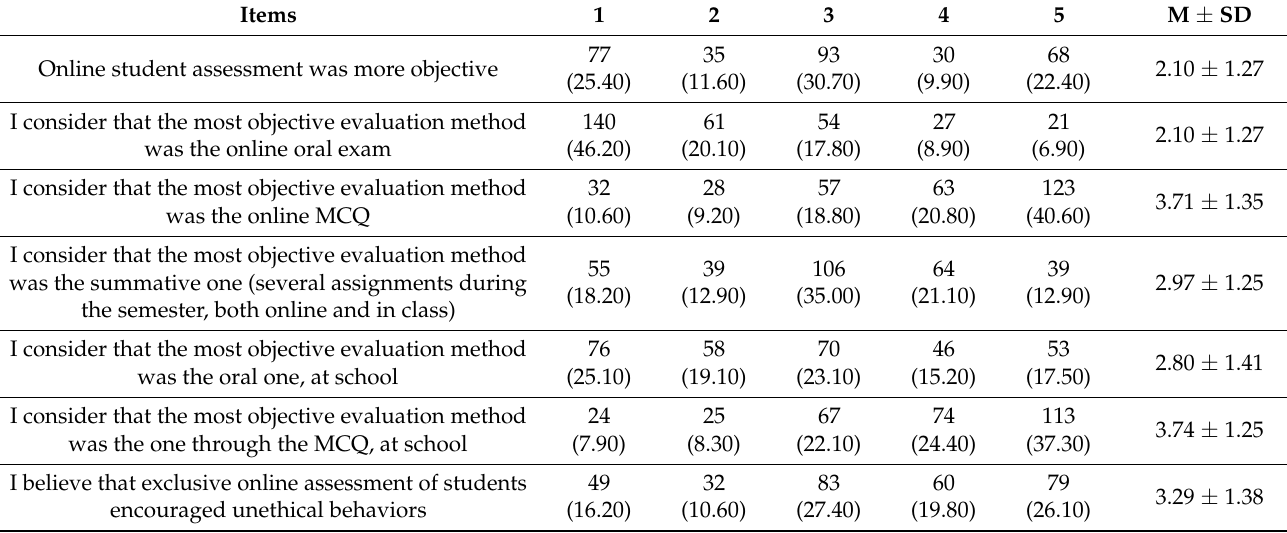
Table 5. Self-rated items regarding students ‘opinions related to online evaluation 1